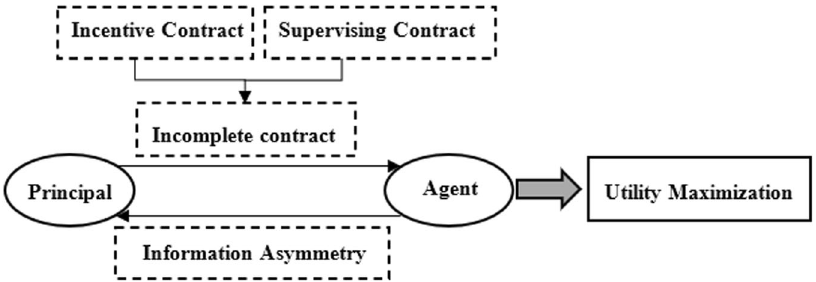
Fig. 1 Schematic diagram of principal – agent relationship. In one principal – agent relationship with incomplete regulation and incentive contracts, agents with information and resource advantages will maximize their utility through the incomplete contract